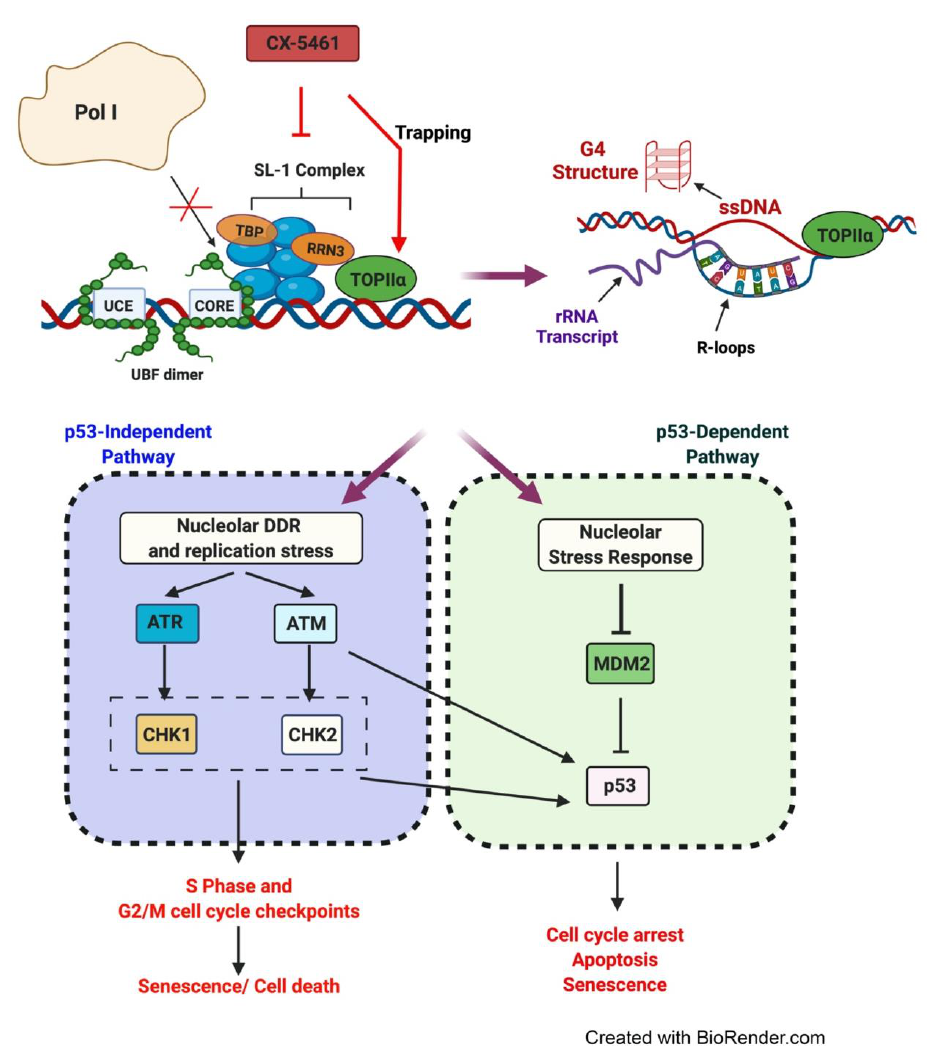
Figure 6. The mechanism of action of CX-5461. CX-5461 inhibits the binding of SL-1 complex to the rDNA promoter region, which in turn prevents the formation of the pre-initiation complex. Furthermore, CX-5461 can induce aberrant rDNA chromatin structures including the formation of single-stranded DNA (ssDNA), stabilization of R-loops and G4 structures, which also leads to inhibition of Pol I transcription, recruitment of TOP2 to resolve topological stresses and subsequent TOP2 poisoning. CX-5461-mediated response involves p53-dependent and -independent pathways. CX-5461 induces activation of the nucleolar stress response which leads to inhibition of Mdm2 and subsequent activation of p53 via multiple pathways. CX-5461 also induces the nucleolar DDR response via activation of ATM and ATR leading to activation of downstream checkpoint kinases CHK1 and CHK2 resulting in cell cycle arrest.